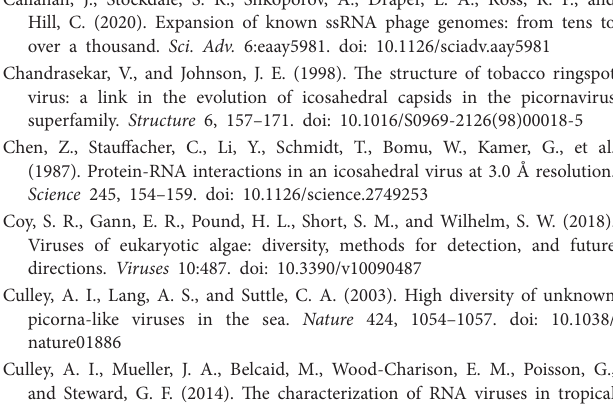
ultrafast bootstrap replications. The scale indicates substitutions per site. Presented are GenBank acc. nos. and virus names. The respective genera are indicated. Colour code: aparaviruses, dark brown; bacillarnaviruses, blue; cripaviruses, light blue; kusarnaviruses, ochre; labyrnaviruses, light green; locarnaviruses, dark blue; marnaviruses, magenta; salisharnaviruses, dark green; sogarnaviruses, red; triatoviruses, brown, untypeable viruses, black. A triangle ( ▲ ) indicates viruses of the present study. Blue boxes indicate viruses with unusual genome layout (capsid protein-encoding gene region at 5'-end, nonstructural polyprotein-encoding gene region at the 3 ′ -end). Yellow boxes indicate four dicistrovirus-like sequence clusters. Supplementary Figure 2 | Phylogenetic analysis of the capsid protein- encoding sequences of dicistroviruses and marnaviruses. Two-hundred forty-two sequences of acknowledged dicistroviruses, marnaviruses and unassigned candidate viruses were aligned with MEGA. The tree was inferred with IQ-Tree 2, optimal substitution model: GTR + F + R9. Numbers at nodes present bootstrap values obtained after 50,000 ultrafast bootstrap replications. The scale indicates substitutions per site. Presented are GenBank acc. nos. and virus names. The respective genera are indicated. Colour code: aparaviruses, dark brown; bacillarnaviruses, blue; cripaviruses, light blue; kusarnaviruses, ochre; labyrnaviruses, light green; locarnaviruses, dark blue; marnaviruses, magenta; salisharnaviruses, dark green; sogarnaviruses, red; triatoviruses, brown, untypeable viruses, black. A triangle ( ▲ ) indicates viruses of the present study. Supplementary Figure 3 | Phylogenetic analysis of the VP1-to-helicase gene region of 15 acknowleged iflavirus strains, 20 candidate strains and Havel picorna-like viruses 14 and -129. The tree was inferred with IQ-Tree 2, optimal substitution model: GTR + F + R5. Numbers at nodes present bootstrap values obtained after 50,000 ultrafast bootstrap replications. The scale indicates substitutions per site. Presented are GenBank acc. nos. and virus names. Unassigned viruses are printed in blue. A triangle ( ▲ ) indicates the viruses of the present study. Supplementary Figure 4 | (A) Phylogenetic analysis of the capsid protein- encoding gene region (P1) of Havel picorna-like virus 29 and 162 picornaviruses. The tree was inferred with IQ-Tree 2, optimal substitution model: GTR+F+R9. Presented are GenBank acc. nos., genera (printed in italics and bold), virus names and strain designations (in square brackets). Sub-family names where available are given to the right. A triangle ( ▲ ) indicates the virus of the present study. Numbers at nodes present bootstrap values obtained after 50,000 ultrafast bootstrap replications. The scale indicates substitutions per site. (B) Phylogenetic analysis of the proteinase/polymerase-encoding gene region (3CD) of Havel picorna-like virus 29 and 162 picornaviruses. The tree was inferred with IQ-Tree 2, optimal substitution model: GTR+F+R8. Presented are GenBank acc. nos., genera (printed in italics and bold), virus names and strain designations (in square brackets). Sub-family names where available are given to the right. A triangle ( ▲ ) indicates the virus of the present study. Numbers at nodes present bootstrap values obtained after 50,000 ultrafast bootstrap replications. The scale indicates substitutions per